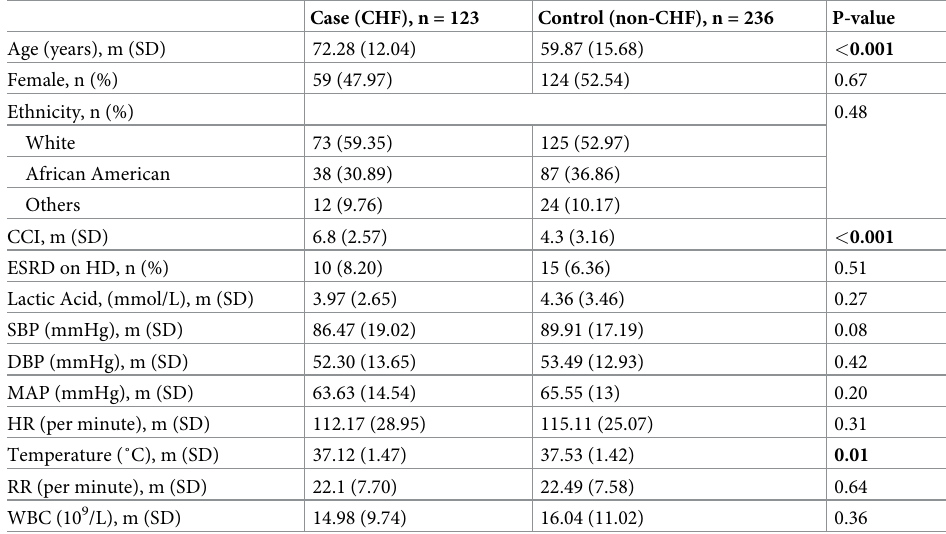
m = mean; n = number; SD = Standard Deviation; CCI = Charlson-Comorbidity Index; ESRD on HD = End-Stage Renal Disease on Hemodialysis; SBP = Systolic Blood Pressure; DBP = Diastolic Blood Pressure; MAP = Mean Arterial Pressure; HR = Heart Rate; RR = Respiratory Rate; WBC = White Blood Cell. Significant P-values are in